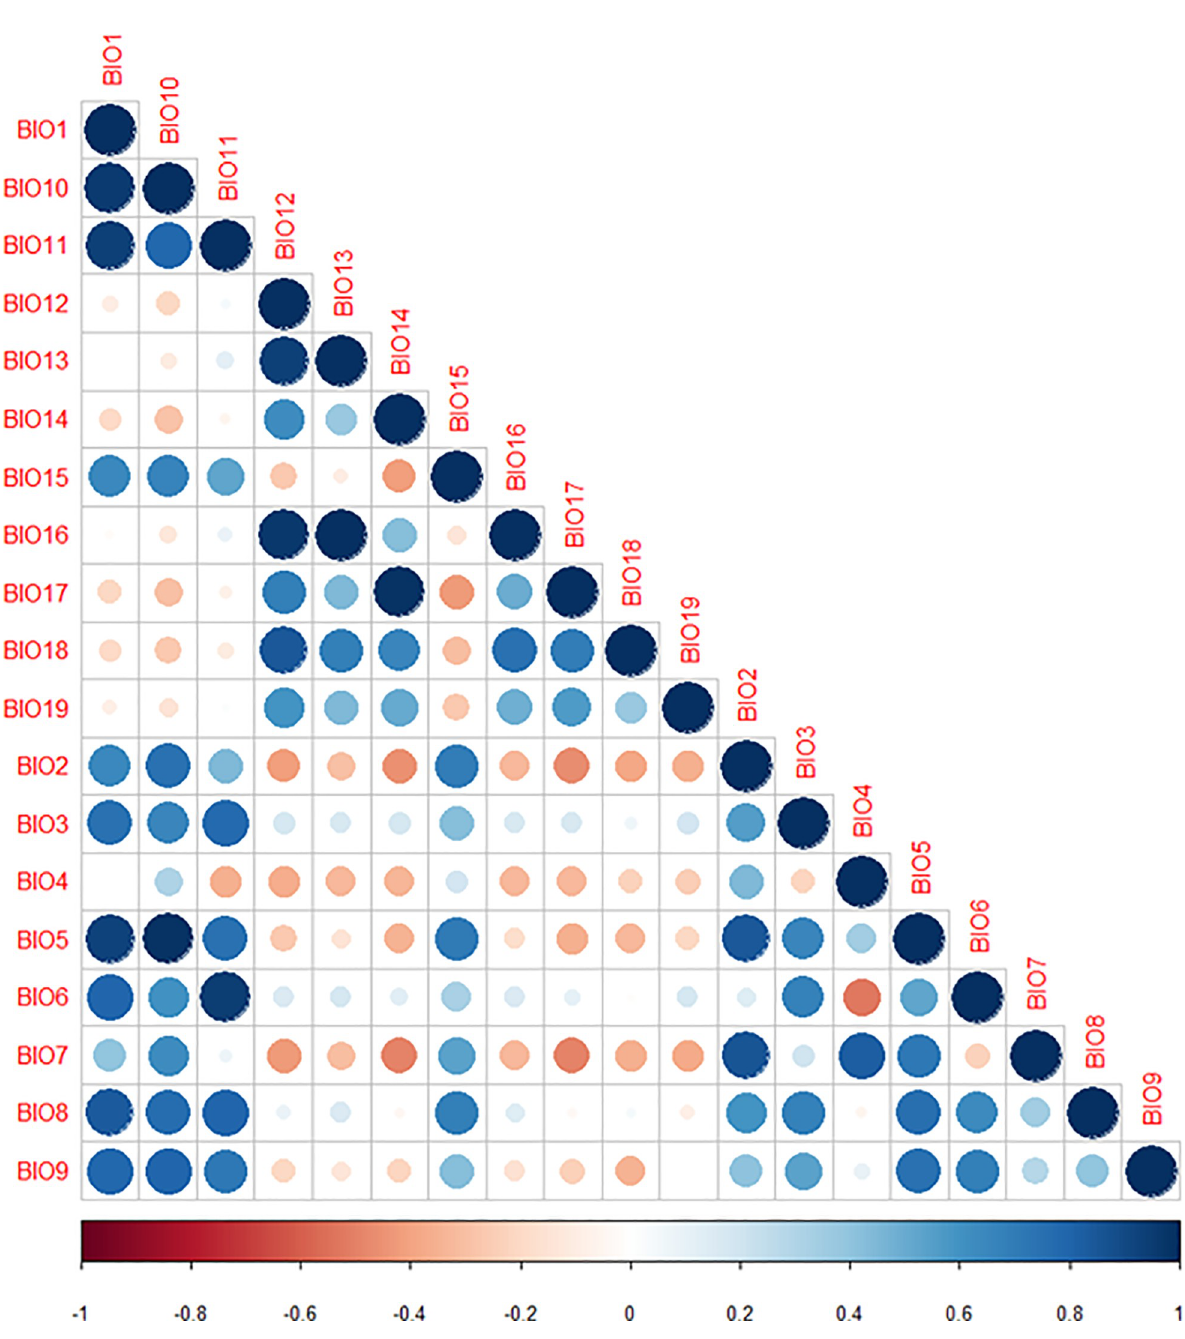
Fig 2. The collinearity matrix for the candidate predictor variables for Bactrocera zonata . The collinearity threshold was set at |r| > 0.7 according to [61]. Darker shades of blue and red indicate high variable collinearity while lighter shades indicate low collinearity. Similarly, the smaller the circle the lower the correlation